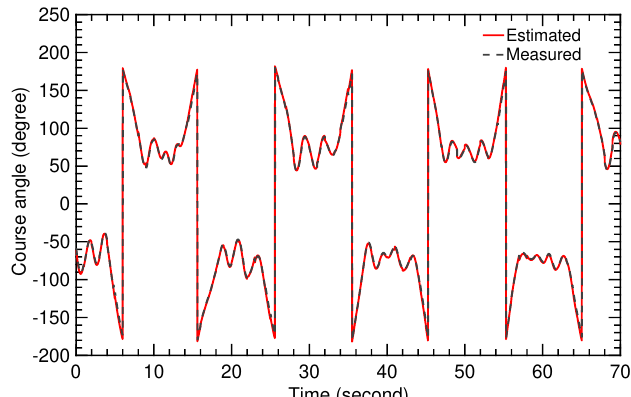
Figure 17. Time history of measured and estimated values of course angle.